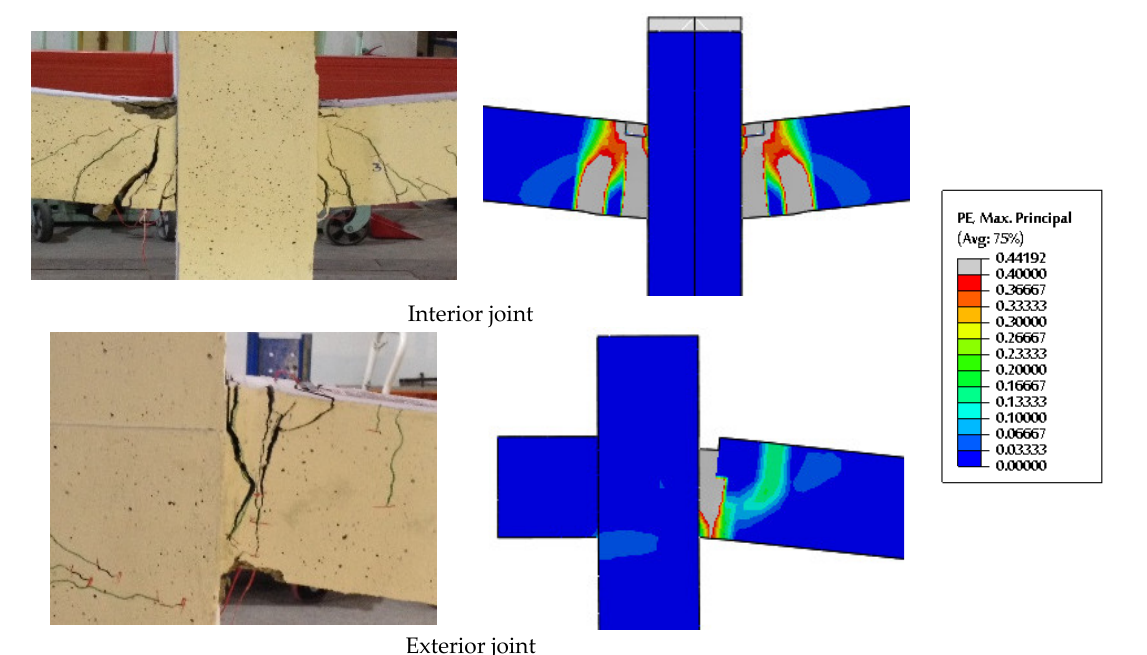
Figure 13. Comparisons of the experimental and FEM crack patterns for the NC frame at failure.